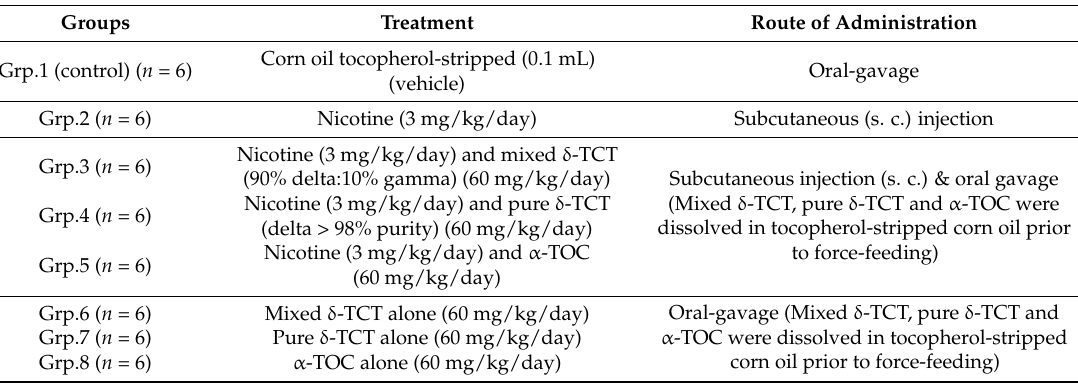
Table 1. Treatments given to the experimental groups for seven consecutive